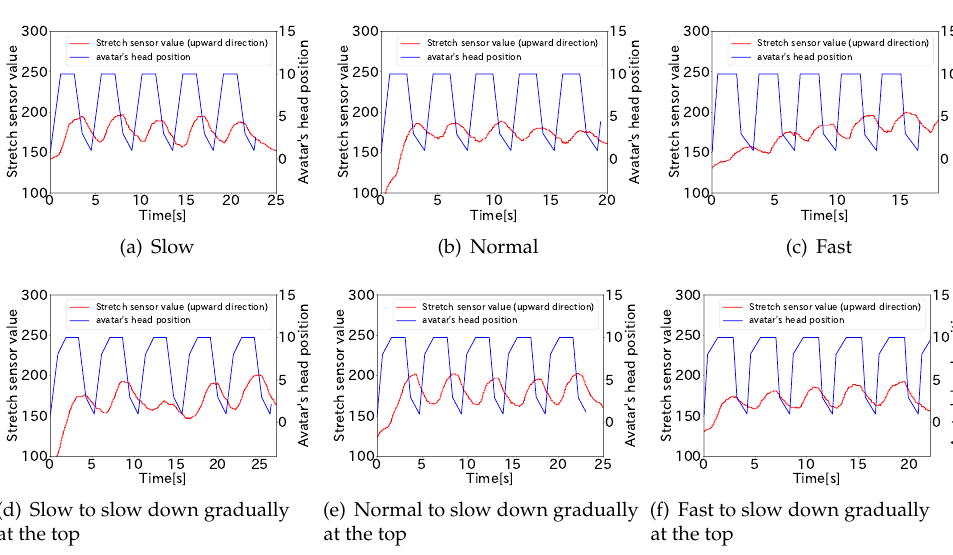
Figure A2. Stretch sensor values at each stretch speed in the upward direction (Participant